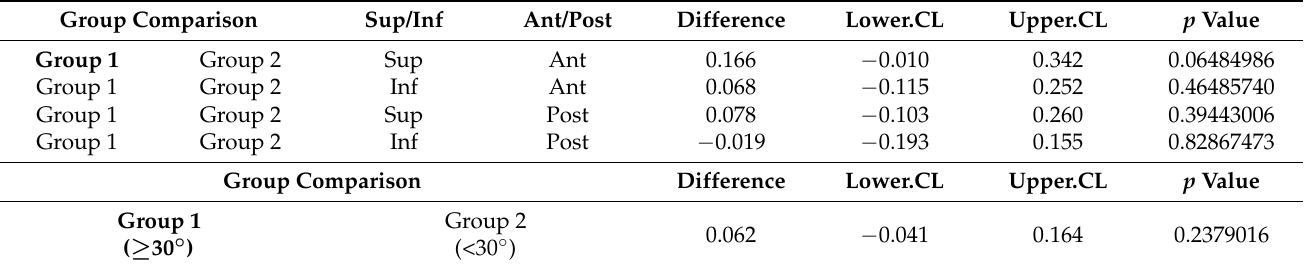
Table 6. Linear mixed models for PPD parameter.